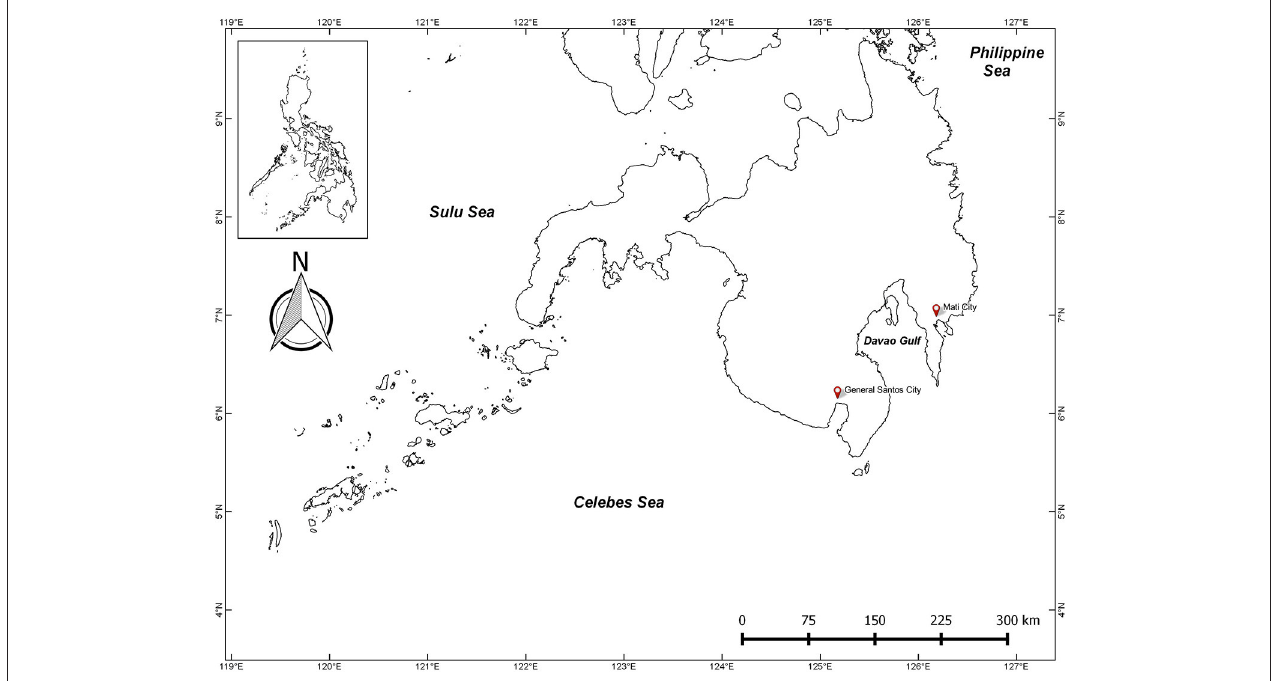
FIGURE 1 | Map of the study sites and the fishing grounds adjacent to